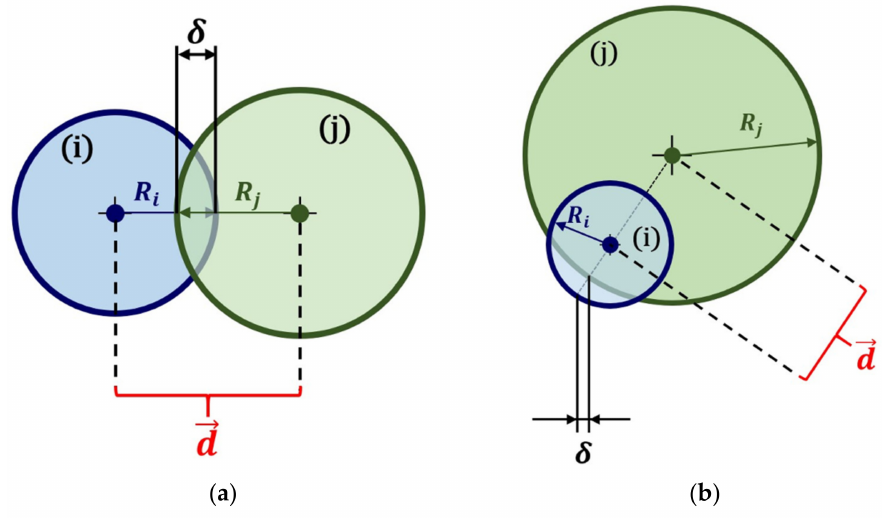
Figure 5. Representation of the two possible interactions between two spheres: ( a ) external contact; ( b ) internal